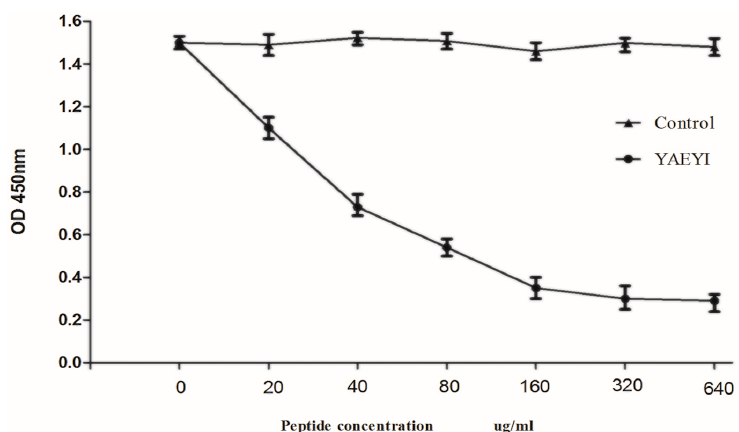
Figure 8. Competitive inhibition of synthetic peptide YAEYI binding to mAb 1F3. A competitive ELISA was performed using the antigen peptide YAEYI as the competitor for the E protein. Values represent three independent experiments with triplicate determinations included in each experiment ( p < 0.05, Student’s t -test).